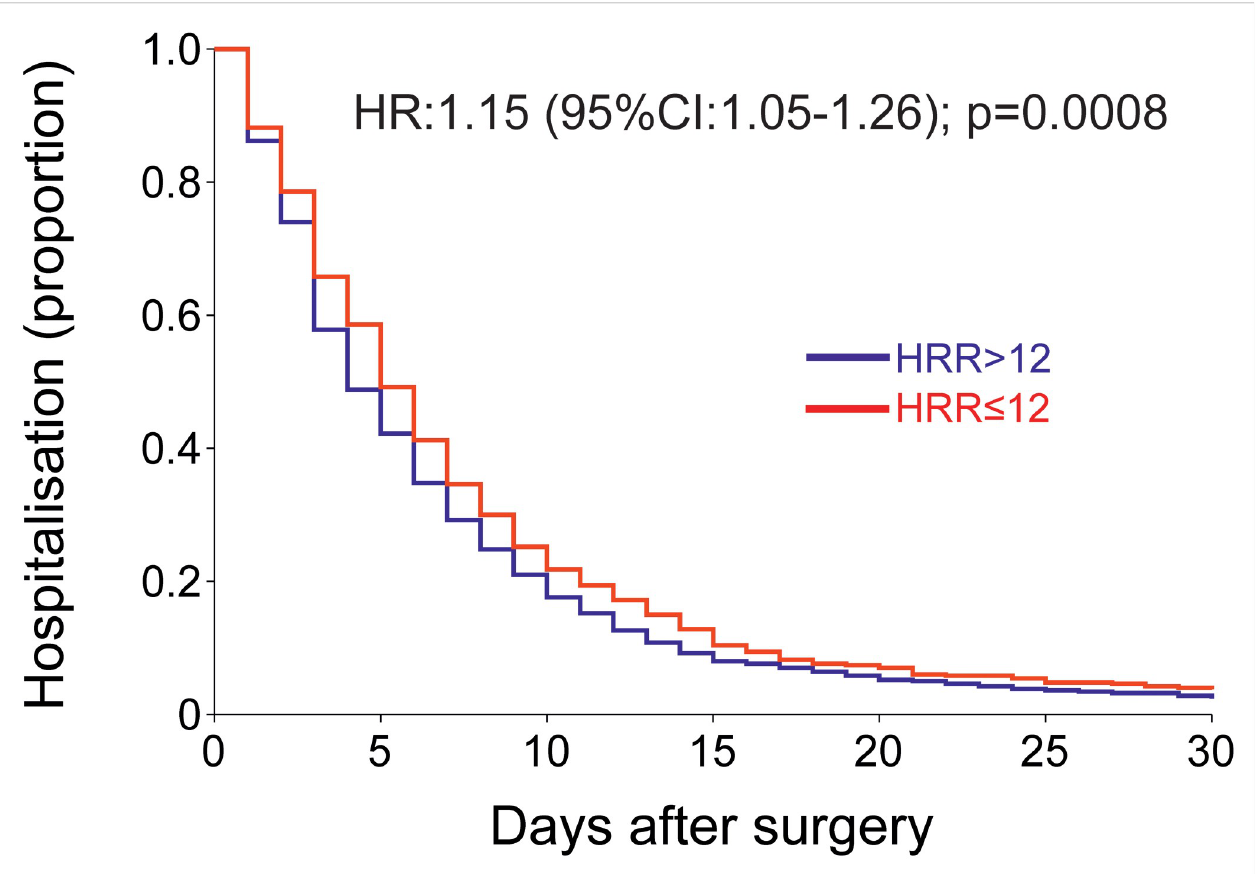
Fig 3. Delayed heart rate and postoperative outcome. Unadjusted Kaplan-Meier estimator for all surgery types showed that delayed heart rate recovery was associated with prolonged hospital stay (HR: 1.15 (95%CI:1.05–1.26); p = 0.0008).